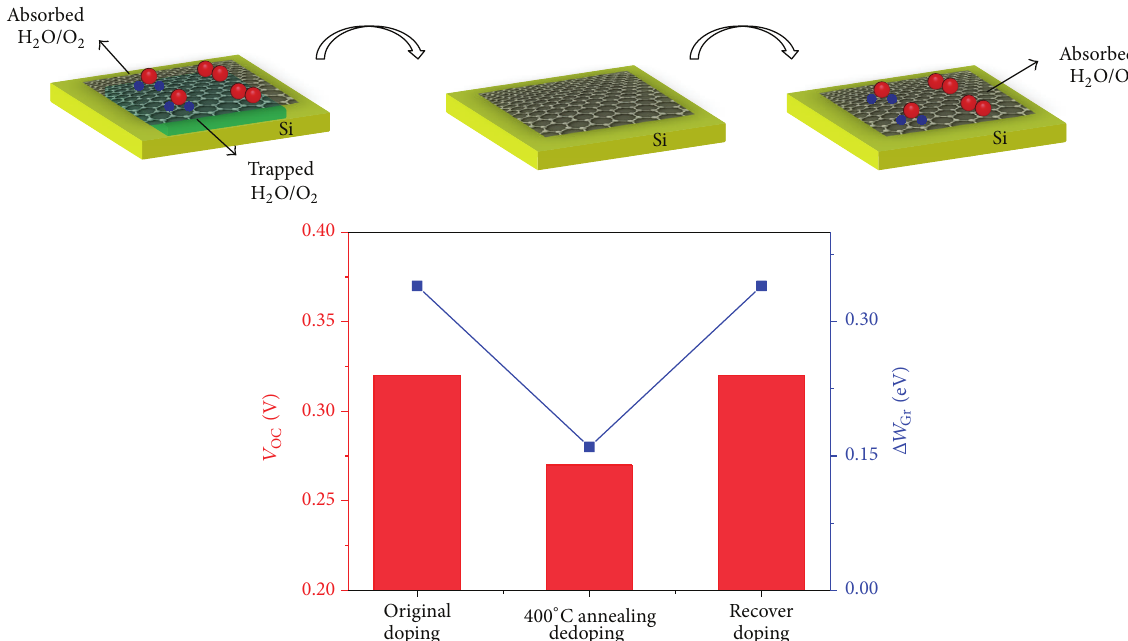
of the Gr-Si solar OC